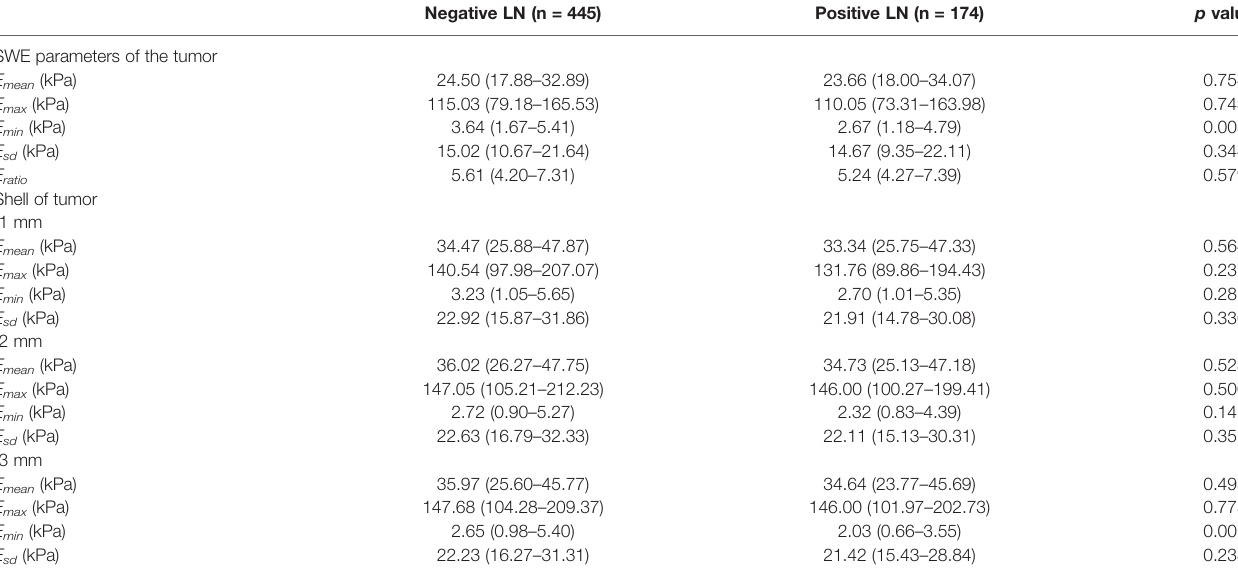
TABLE 3 | Quantitative evaluation of SWE in the internal and peritumor tissues between positive and negative LN metastasis groups. Negative LN (n = 445) Positive LN (n = 174)